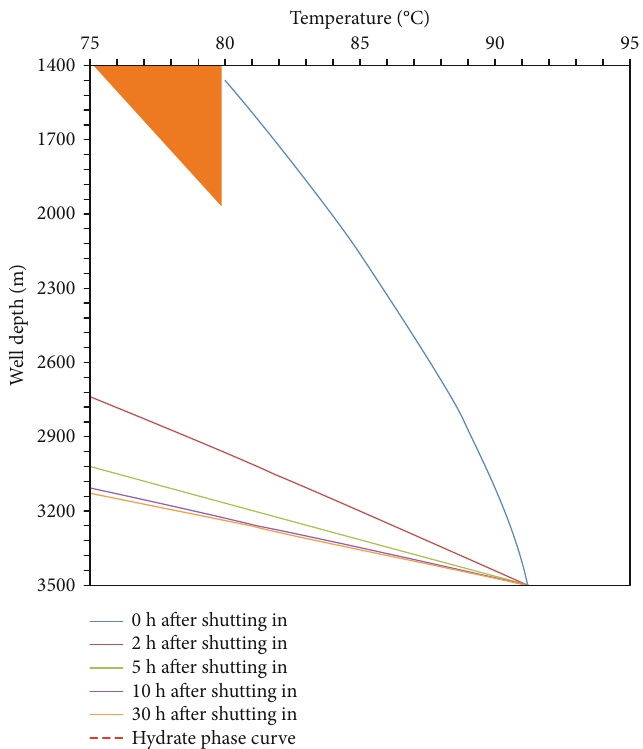
Figure 6: Hydrate formation region prediction at shut-in